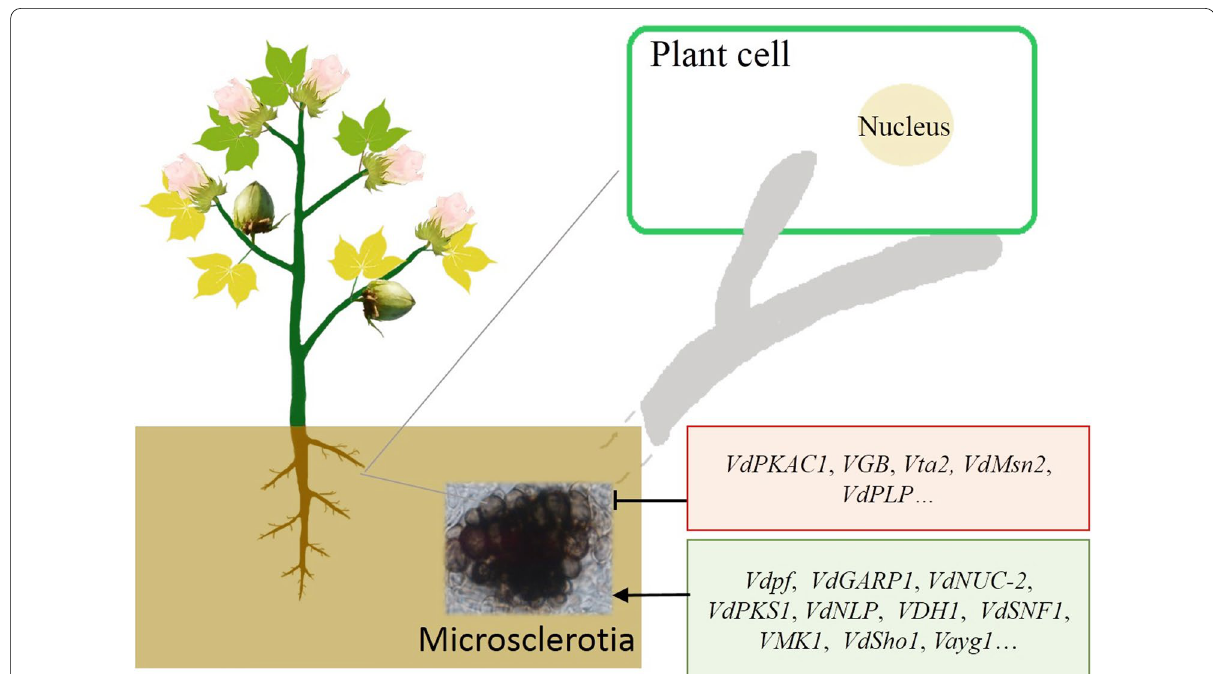
Fig. 1 The simple schematic diagram of the infection process of Verticillium dahliae in cotton. As the initial source of infection, microsclerotia survives in the soil for a long time. Once the conditions are suitable, the microsclerotia germinates to form hyphae and infects cotton root tips. Some postive/negative regulation genes are involved in microsclerotia